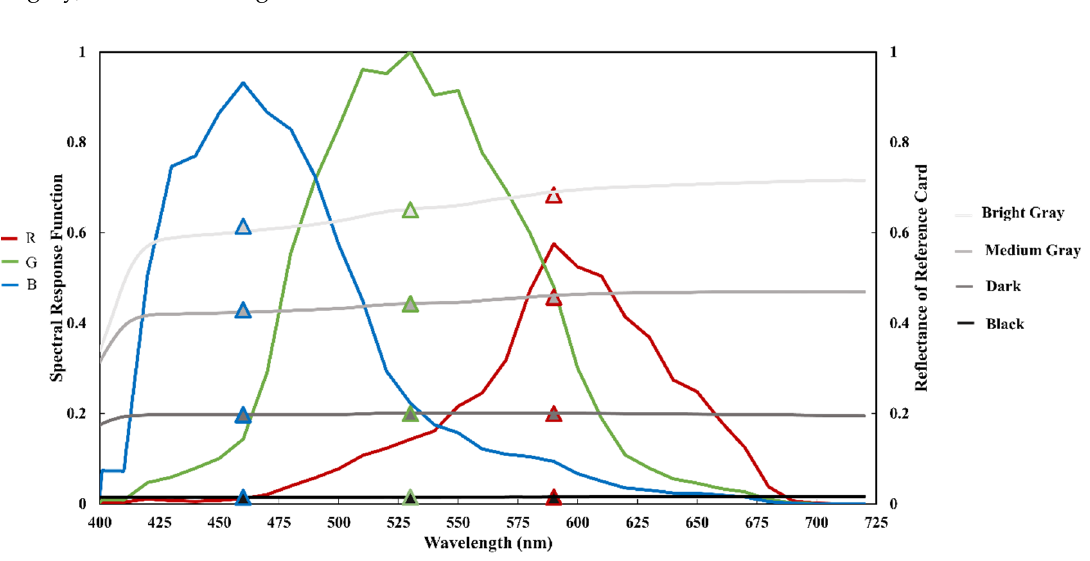
Figure 2. Spectral response functions of the Canon 50D RGB bands (red, green, and blue curves), the reflectance curves of the four reference cards (bright gray, medium gray, dark gray, and black curves), and results of the equivalent reflectance of the reference cards in the Canon 50D RGB bands (triangles).